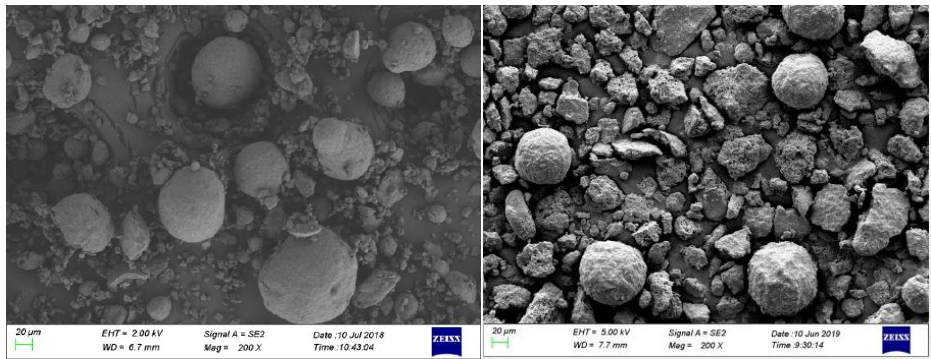
Figure 7. SEM of lost catalyst in FCC unit caused by surface abrasion ( left ) and high-velocity stream striking ( right ).